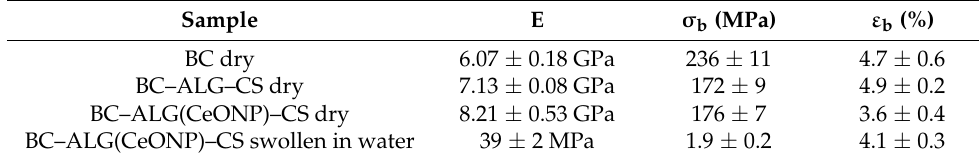
Table 2. Mechanical properties of BC, BC–ALG–CS, and BC–ALG(CeONP)–CS films.